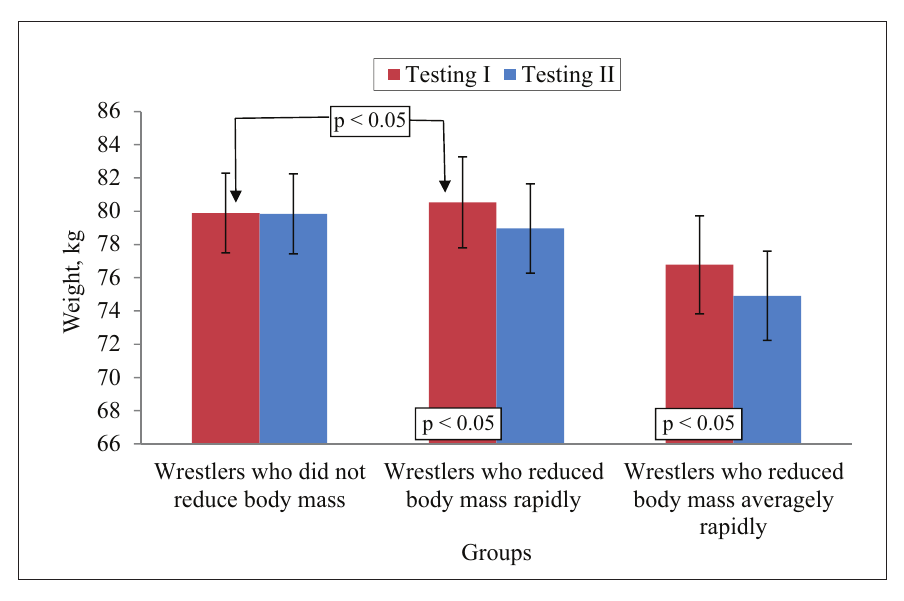
Figure 2. Wrestlers’ body mass changes